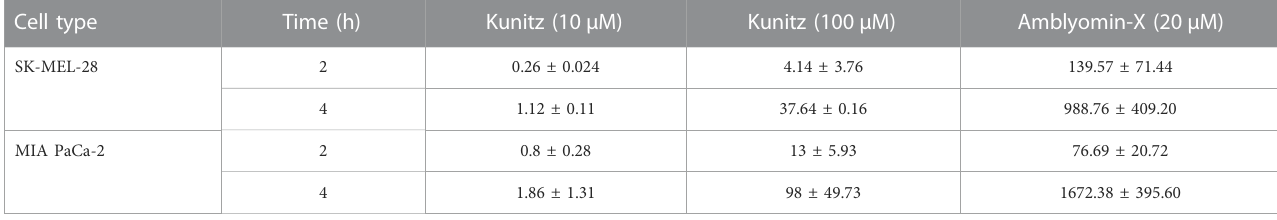
TABLE 4 Cellular-uptake ef fi ciency low of Kunitz molecule. Tumor cells were treated with Alexa-Fluor 488-labeled molecules at indicated times. Fluorescence were monitored by a Molecular Devices ImageXpress Micro Confocal plate-scanning microscope (Molecular Devices, Sunnyvale, CA). Vesicles counts were analyzed using MetaXpress software (Molecular Devices, CA) with Trans fl uor Application Module.